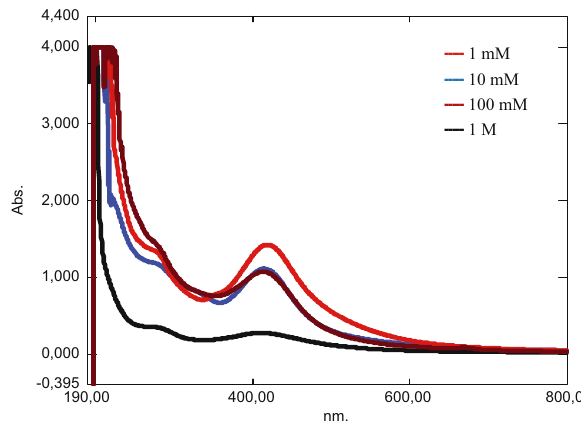
Figure 7: UV - Vis spectra showing the e ff ect of NaCl stress on the deterioration and stability of the bioinspired silver NPs of T. govanianum .